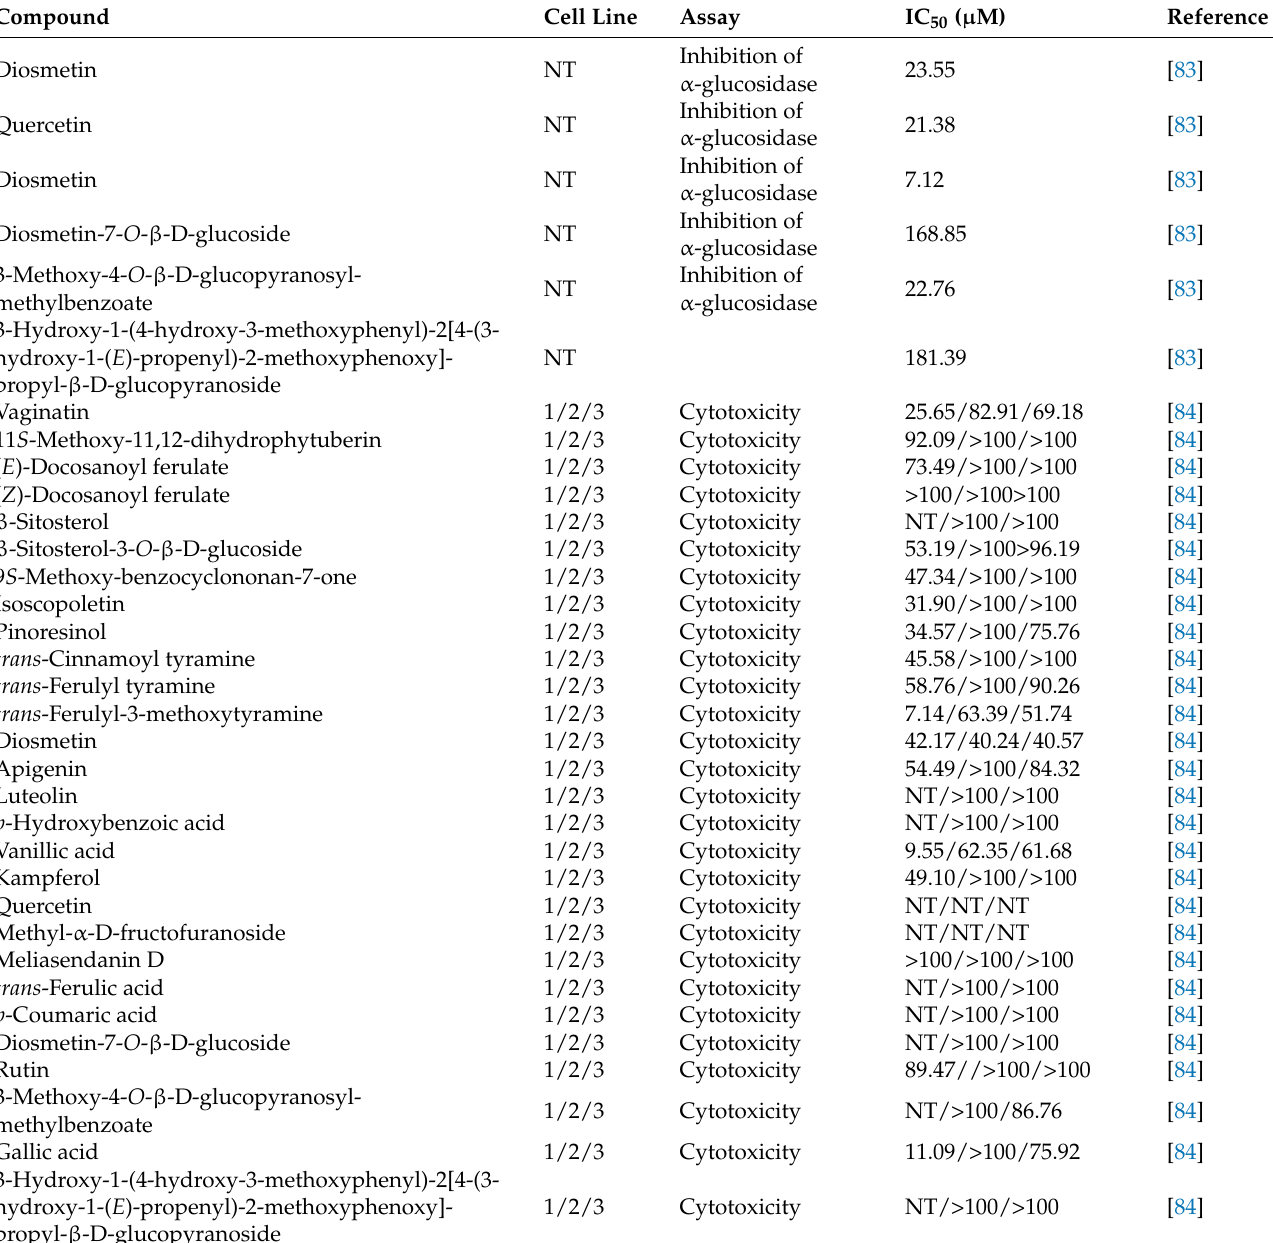
Table 1. Biological activities of isolated compounds of the aerial parts of Lycium schweinfurthii (adapted from